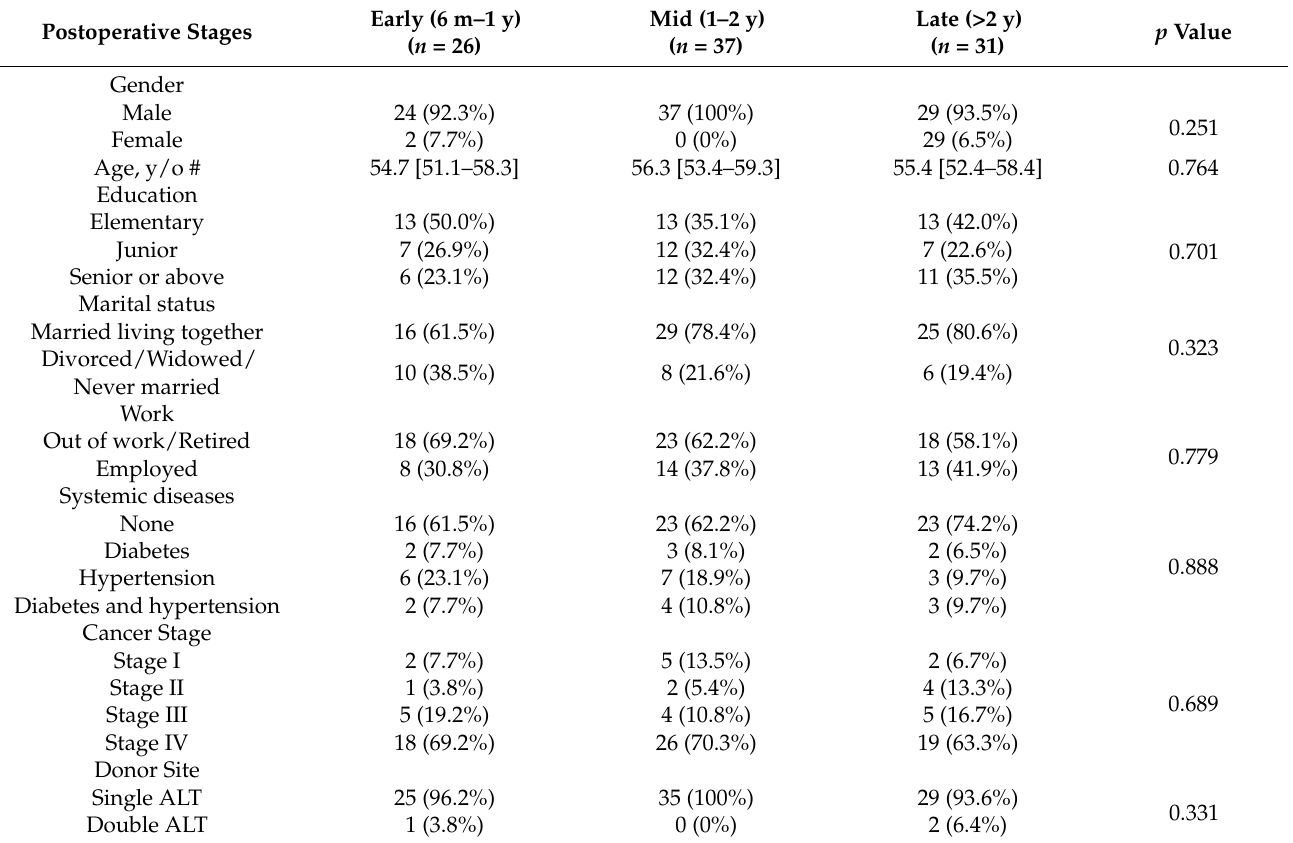
Table 1. Demographic data of patients included in each group following anterolateral thigh flap